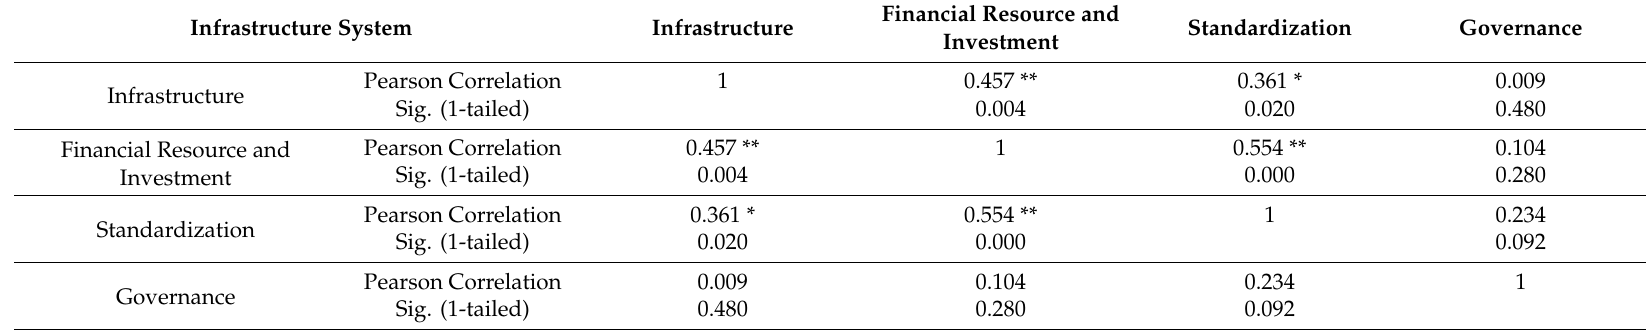
Table A2. Pearson’s correlation.